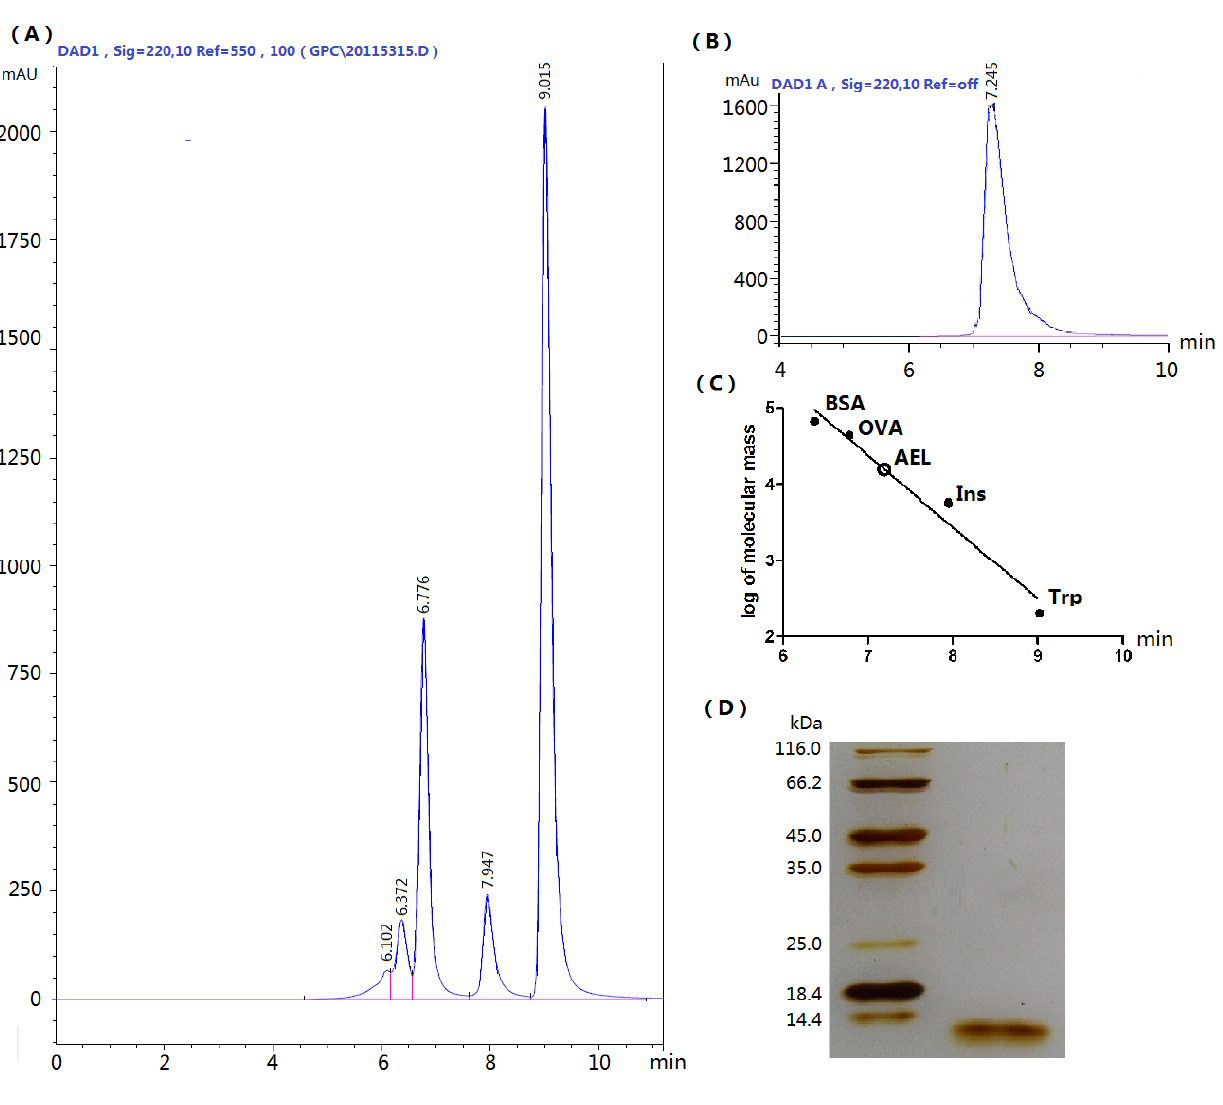
Figure 2. ( A ) Standard proteins analyzed by size-exclusion HPLC chromatography. Standard markers: bovine serum albumin (BSA, 67 kDa), ovalbumin (OVA, 44 kDa), insulin (Ins, 5.7 kDa) and tryptophan (Trp, 0.2 kDa); ( B ) AEL by size-exclusion HPLC; ( C ) Standard curve representing native molecular weight of AEL by size-exclusion HPLC; ( D ) SDS-PAGE, pH 8.3 purified AEL using 12% gel (running time 3 h at a constant 100 V). Mr, Molecular weight markers (from top to bottom): β -galactosidase (116.0 kDa); bovine serum albumin (66.2 kDa); ovalbumin (45.0 kDa); lactate dehydrogenase (35.0 kDa); REase Bsp981 (25.0 kDa); β -lactoglobulin (18.4 kDa); and lysozyme (14.4 kDa). The gels were stained with silver